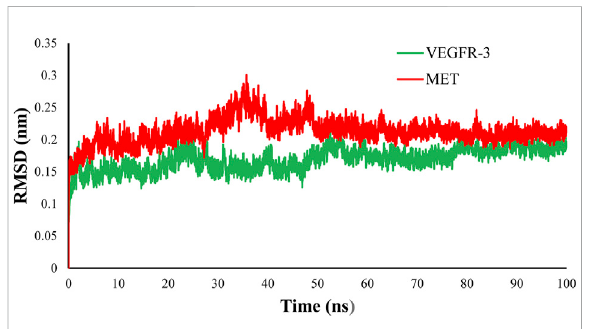
FIGURE 8 RMSD evaluation of complex of CM9 with MET kinase (pdb: 3LQ8) (red) and established FLT4 (VEGFR3) homology model (green). To resolve the MD equilibrium time range, the RMSD plot oftheproteinbackboneatoms versus timefortheinteraction of the CM9 with MET kinase (pdb:3LQ8) (red) and established VEGFR3 homology model (green) were investigated. The equilibrium time ranges of 45 and 60 ns were observed for complexes of CM9 with MET and VEGFR3 kinases, respectively. The RMSD fi gure was drawn by Microsoft Excel 2010.